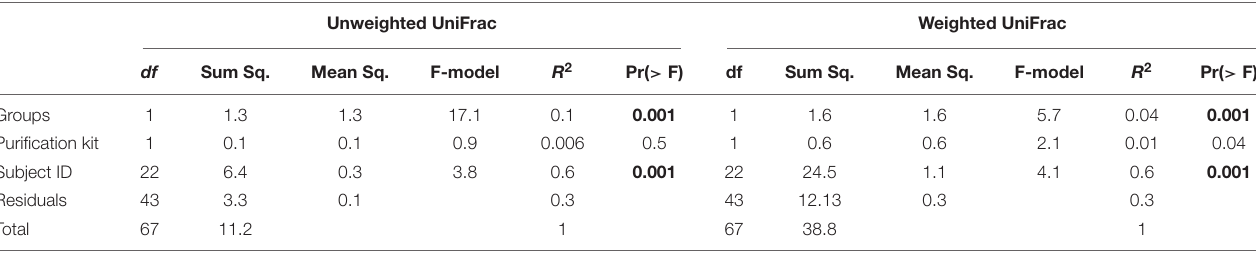
TABLE 3 | Results of permutational multivariate analysis of variance (Adonis) using weighted and unweighted UniFrac dissimilarity matrices using beta diversity values between Groups (PPG-PG), purification kit for DNA extraction employed, and Subject ID. Unweighted UniFrac Weighted UniFrac df Sum Sq. Mean Sq. F-model R 2 Pr( > F) df Sum Sq. Mean Sq.